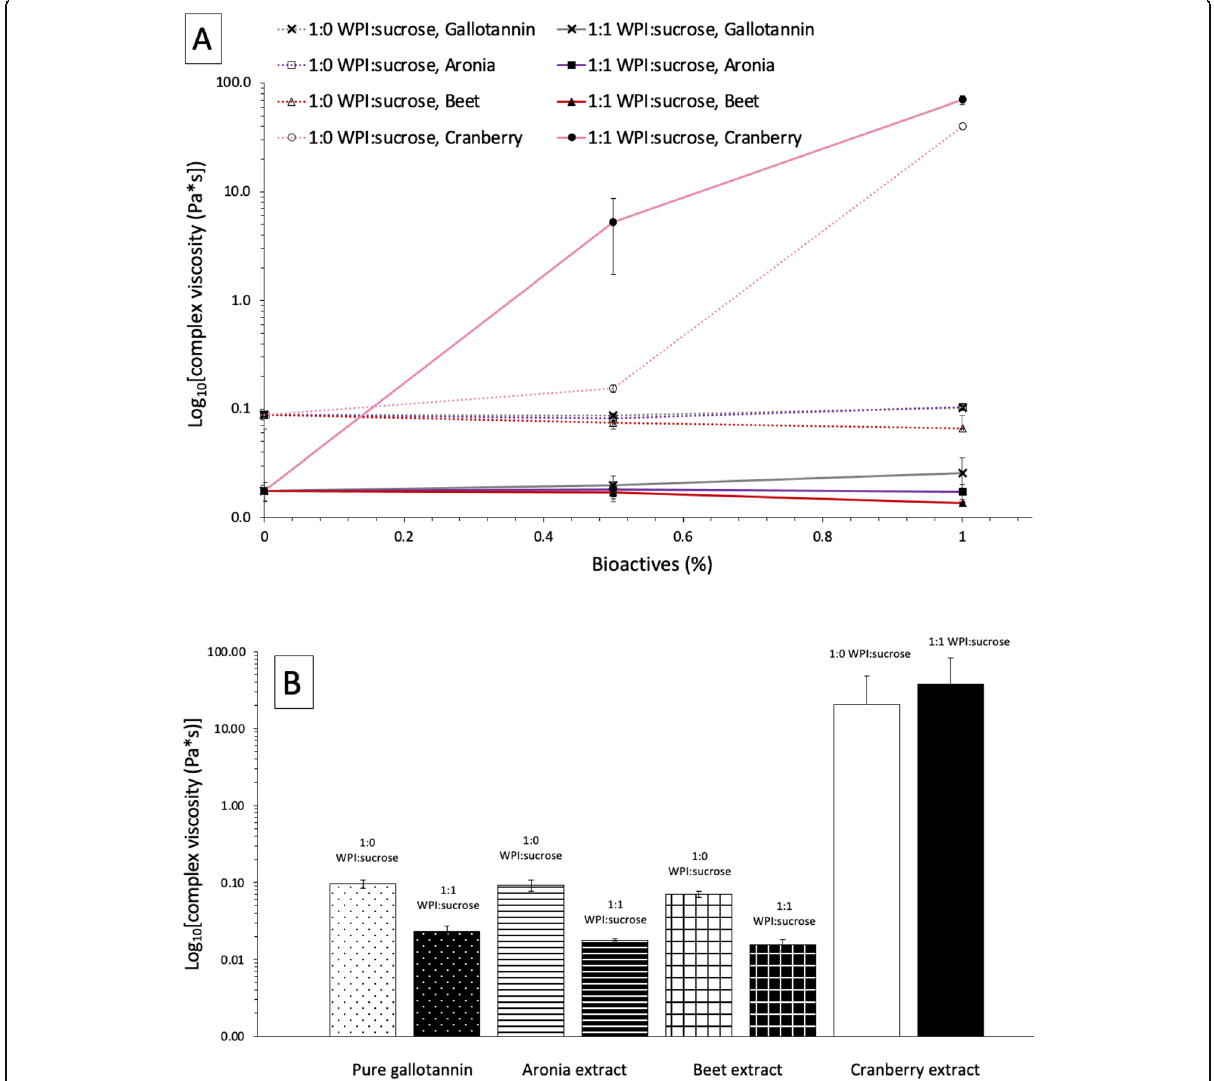
Fig. 7 Effect of bioactives content (%) A on the complex viscosities (Pa*s) of dispersions at 25 °C; the effect of bioactives source B on the averaged complex viscosities of dispersions comprised of 1:0 and 1:1 WPI:sucrose with pure gallotannin, Aronia berry, beet, and cranberry extracts at 0.5 and 1% at 25 °C; ( n = 9). Lines are for guiding purposes only